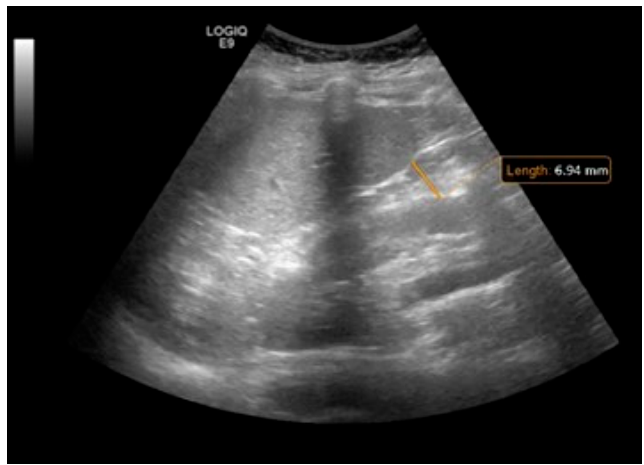
Figure 2. Ultrasound image showing the thickness of the inter-spleno-renal adipose tissue corre- sponding to the inferior renal pole = 6.94 mm. Prepared by the authors. Courtesy of the Pediatric Clinical Hospital Sibiu, Lucian Blaga University of Sibiu.